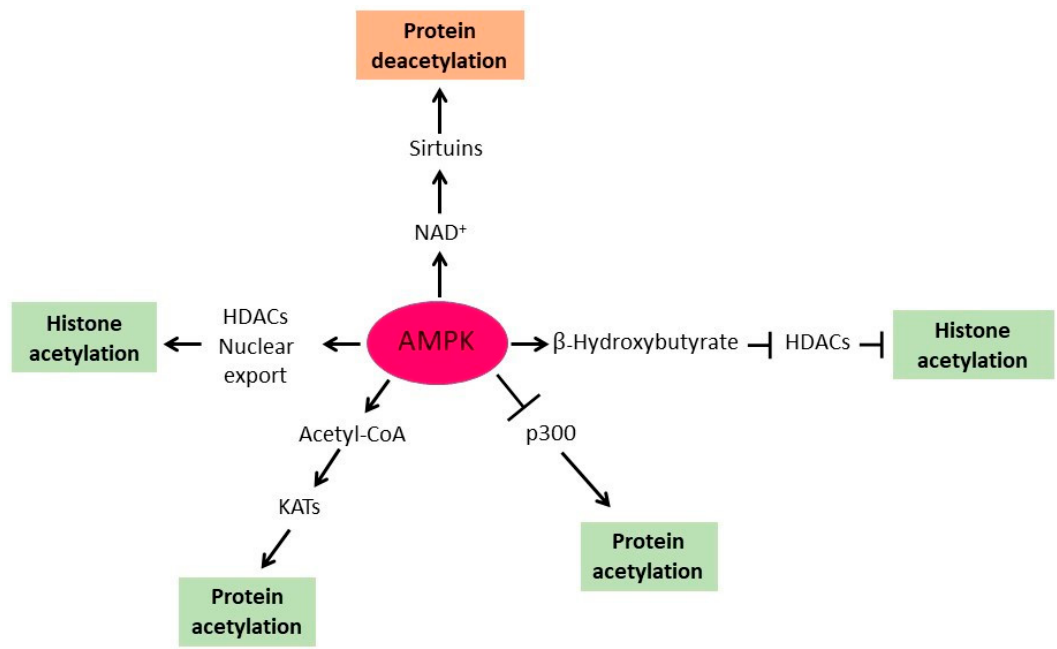
Figure 1. AMP-activated protein kinase (AMPK) regulates protein acetylation by several different mechanisms: (i) AMPK phosphorylates and inhibits acetyl-CoA carboxylase (ACC) and thus